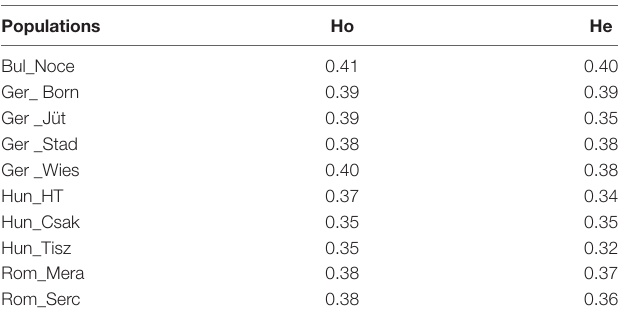
TABLE 3 | Observed (Ho) and expected (He) heterozygosity of buffalo populations de novo genotyped distributed in Bulgaria, Germany, Hungary, and Romania (abbreviations are defined in Table 1 ).